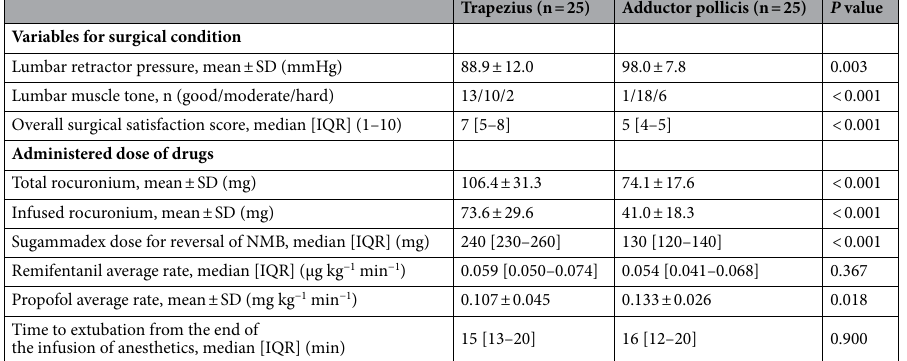
Table 3. Intraoperative outcomes, including variables measured for surgical condition assessment, cumulative dose of rocuronium, average infusion rate of anesthetics, and sugammadex dose for reversal of NMB. NMB indicates neuromuscular blockade; SD standard deviation; IQR interquartile